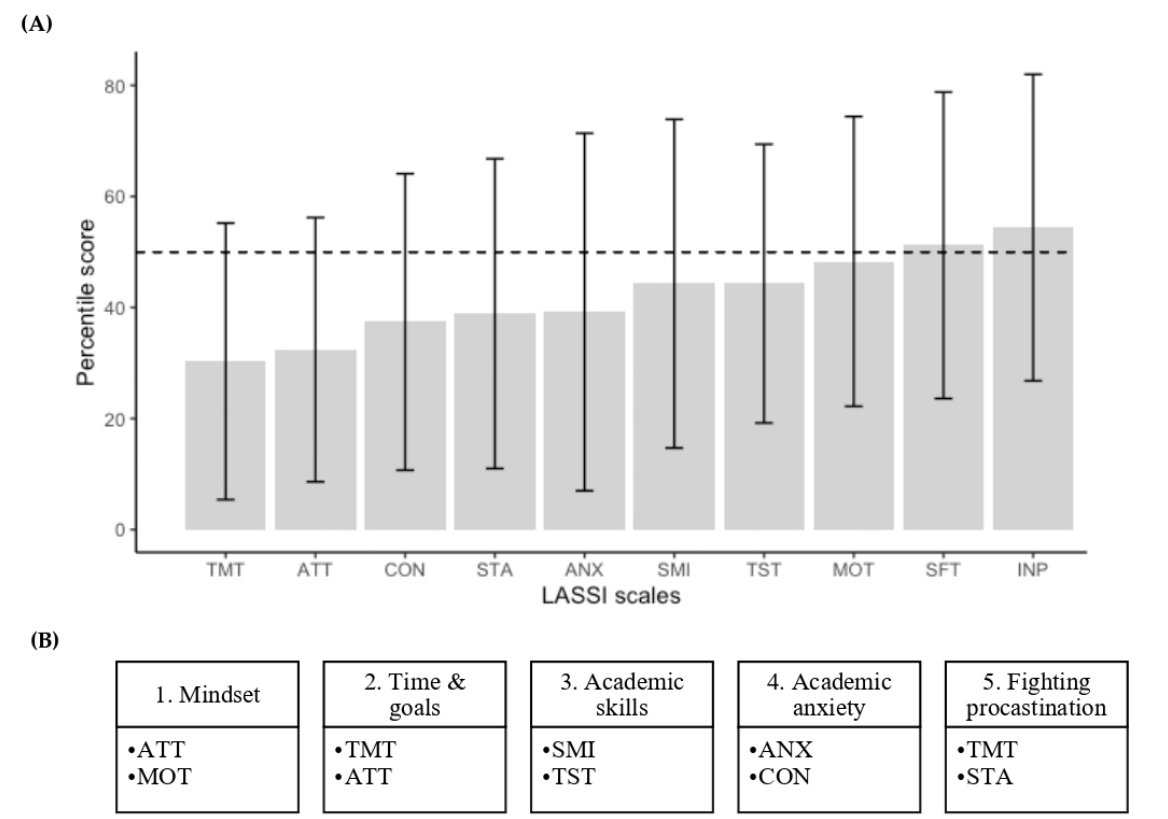
Figure 1. Pre LASSI test scores by scales and planned workshops. Panel ( A ) shows the mean percentile values of the ten LASSI scales before intervention, from the lowest to the highest. The horizontal dashed-black line shows the 50th percentile cut-off value. The error bars represent the standard deviation of the mean value. Panel ( B ) shows the organization of the workshops planned for the intervention phase according to LASSI scales. Abbreviations: INP, Information Processing; SMI, Selecting Main Ideas; TST, Test Strategies; ANX, Anxiety; ATT, Attitude; MOT, Motivation; CON, Concentration; SFT, Self-Testing; STA, Study Aids; and TMT, Time Management.